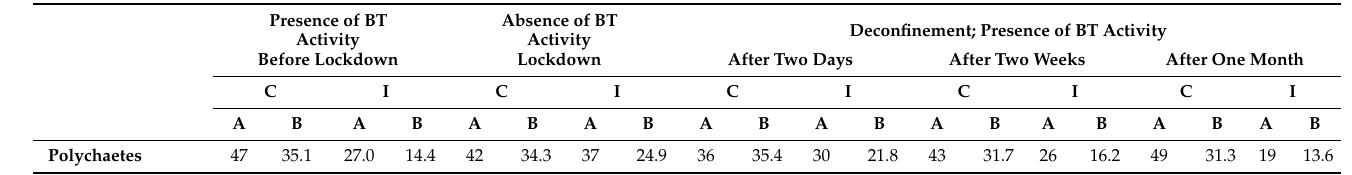
Table 2. Proportion of zoological groups (A: % total abundance; B: % total biomass), the mean taxa number, mean abundance, and mean biomass recorded at the two impacted (I) and two control sta- tions (C) during the five sampling periods: The mean taxa number (number of taxa per 0.2 m 2 ± SD); the mean abundance (number of individuals per m 2 ± SD); the mean biomass (g AFDW per m 2 ± SD); BT: bottom trawling and others groups (echinoderms, cnidarians, and tunicates). Presence of BT